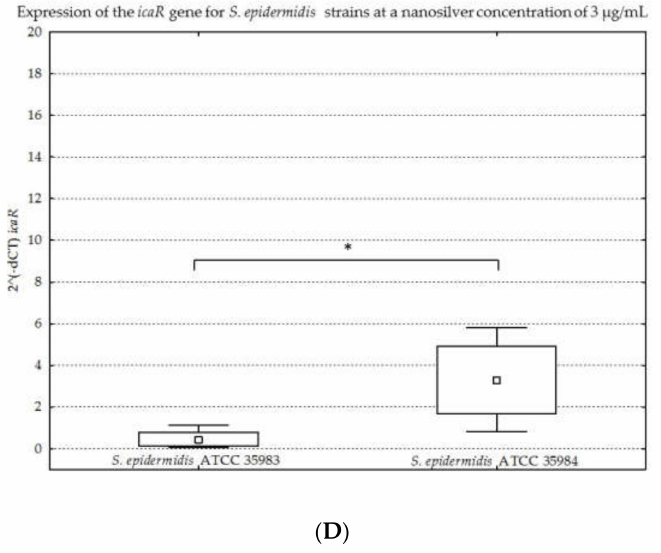
Figure 10. ( A – D ). Gene expression ( icaA , icaB , icaC , icaR ) depending on the strain of S. epidermidis at a nanosilver concentration of 3 µ g/mL, presented as medians and quartiles (Q1 and Q3). Statistical significance: * p <